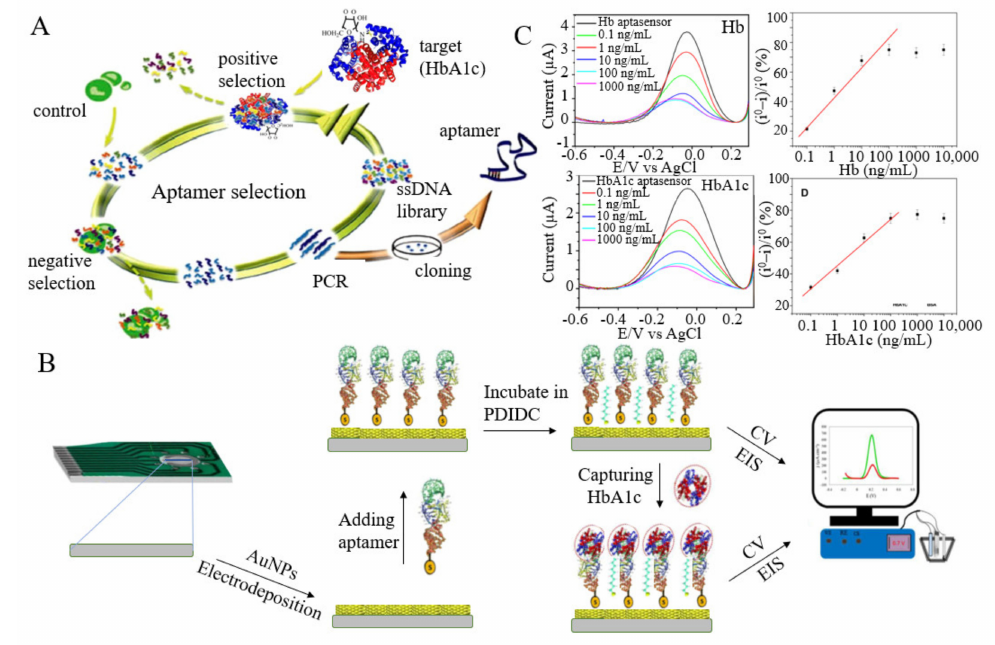
Figure 3. ( A ) SELEX was used to screen suitable molecules bound to HbA1c. ( B ) The manufacture and measurement of the HbA1c sensor (reprint permission has been requested from [52], and it was also adapted from [53]). ( C ) SWV diagram and calibration curve of suitable aptamers of Hb and HbA1c junctions at different concentrations (reprint permission has been requested from